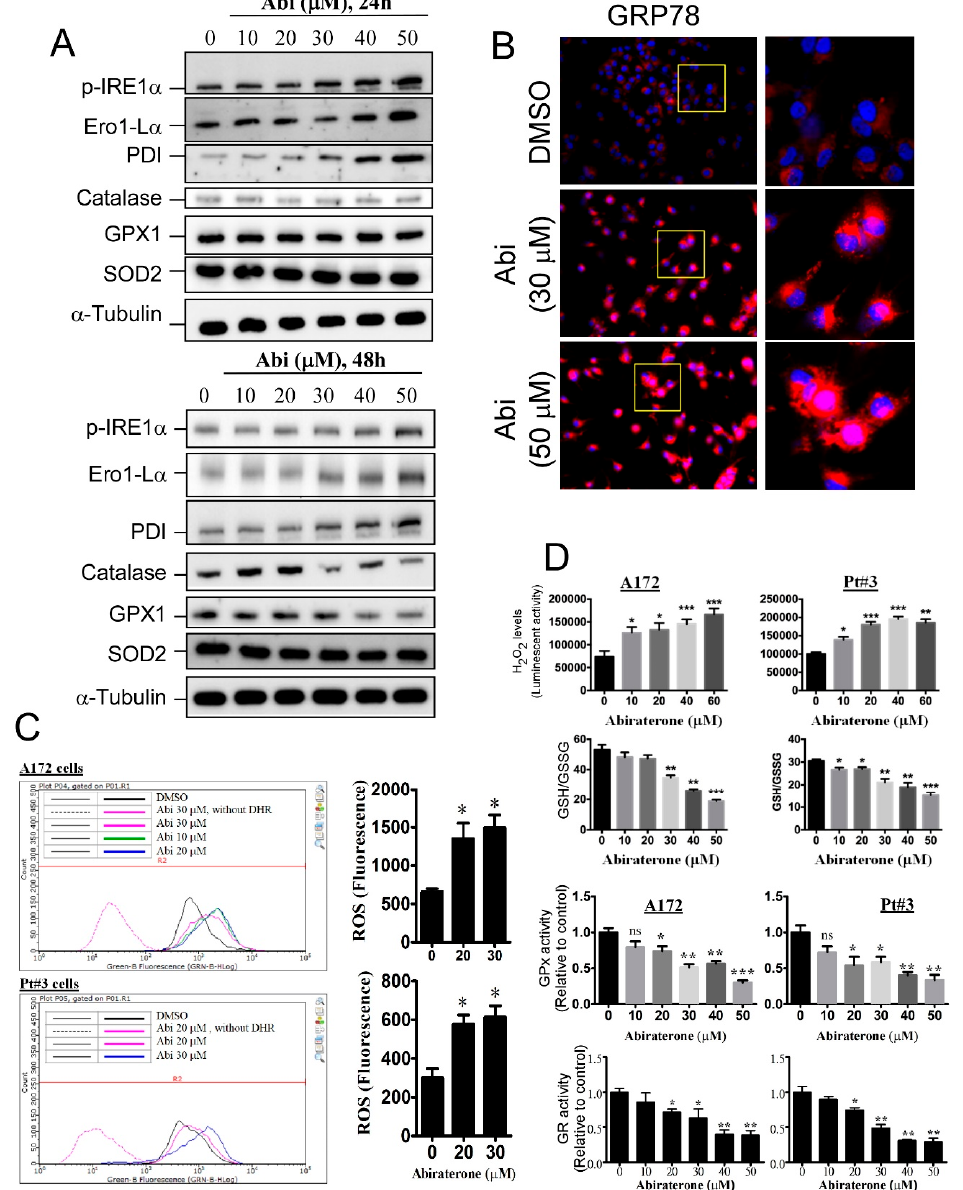
Figure 2. Abi induces endoplasmic reticulum (ER) stress and increases reactive oxygen species (ROS) production in glioblastomas. ( A ) After treatment with Abi, cell lysates were analyzed by western blotting using the indicated antibody. ( B ) After treatment for 24 h, cells were fixed, permeabilized, and stained using the anti-glucose-regulated protein (GRP) 78 antibody. ( C ) After treatment for 48 h, ROS levels in the cells were analyzed by dihydrorhodamine 123 (DHR) using flow cytometry. Data were expressed as mean ± SEM (* p < 0.05). ( D ) E ff ect of Abi on redox reactions. After 48 h of treatment, cells were harvested and analyzed for H 2 O 2 levels, glutathione (GSH) / oxidized glutathione (GSSG) ratio, glutathione peroxidase (GPx) activity, and glutathione reductase (GR) activity. (* p < 0.05, ** p < 0.01, *** p < 0.001). None significance (ns) compared with control was